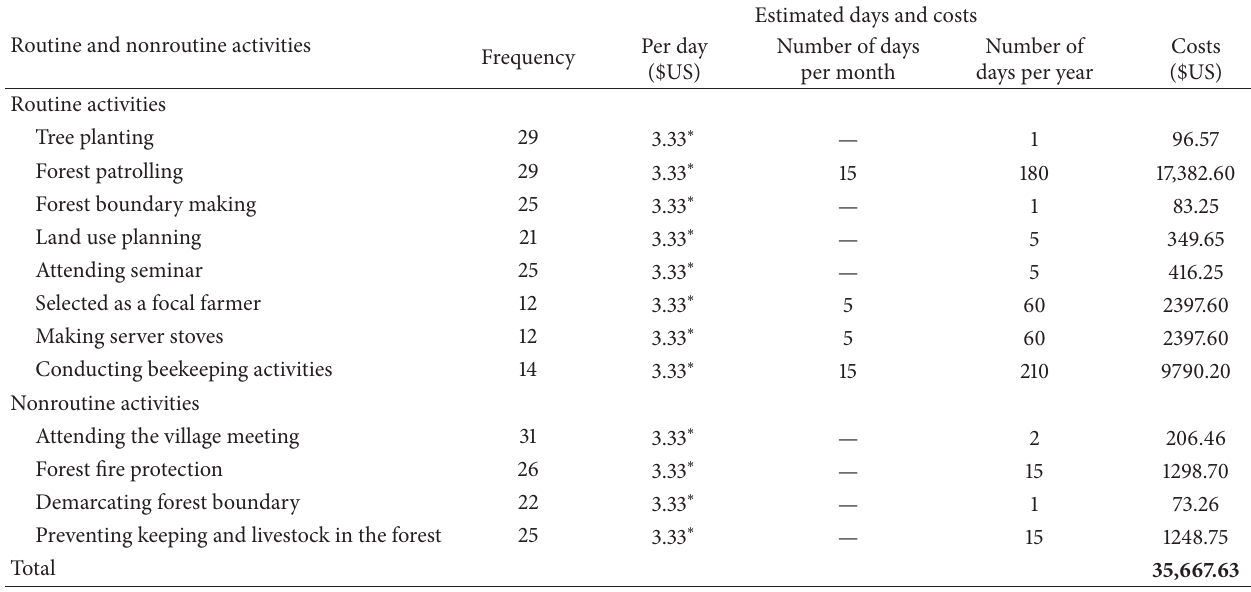
Table 1: Activities and their associated cost incurred by community in managing the ARKFor pilot project. Routine and nonroutine activities